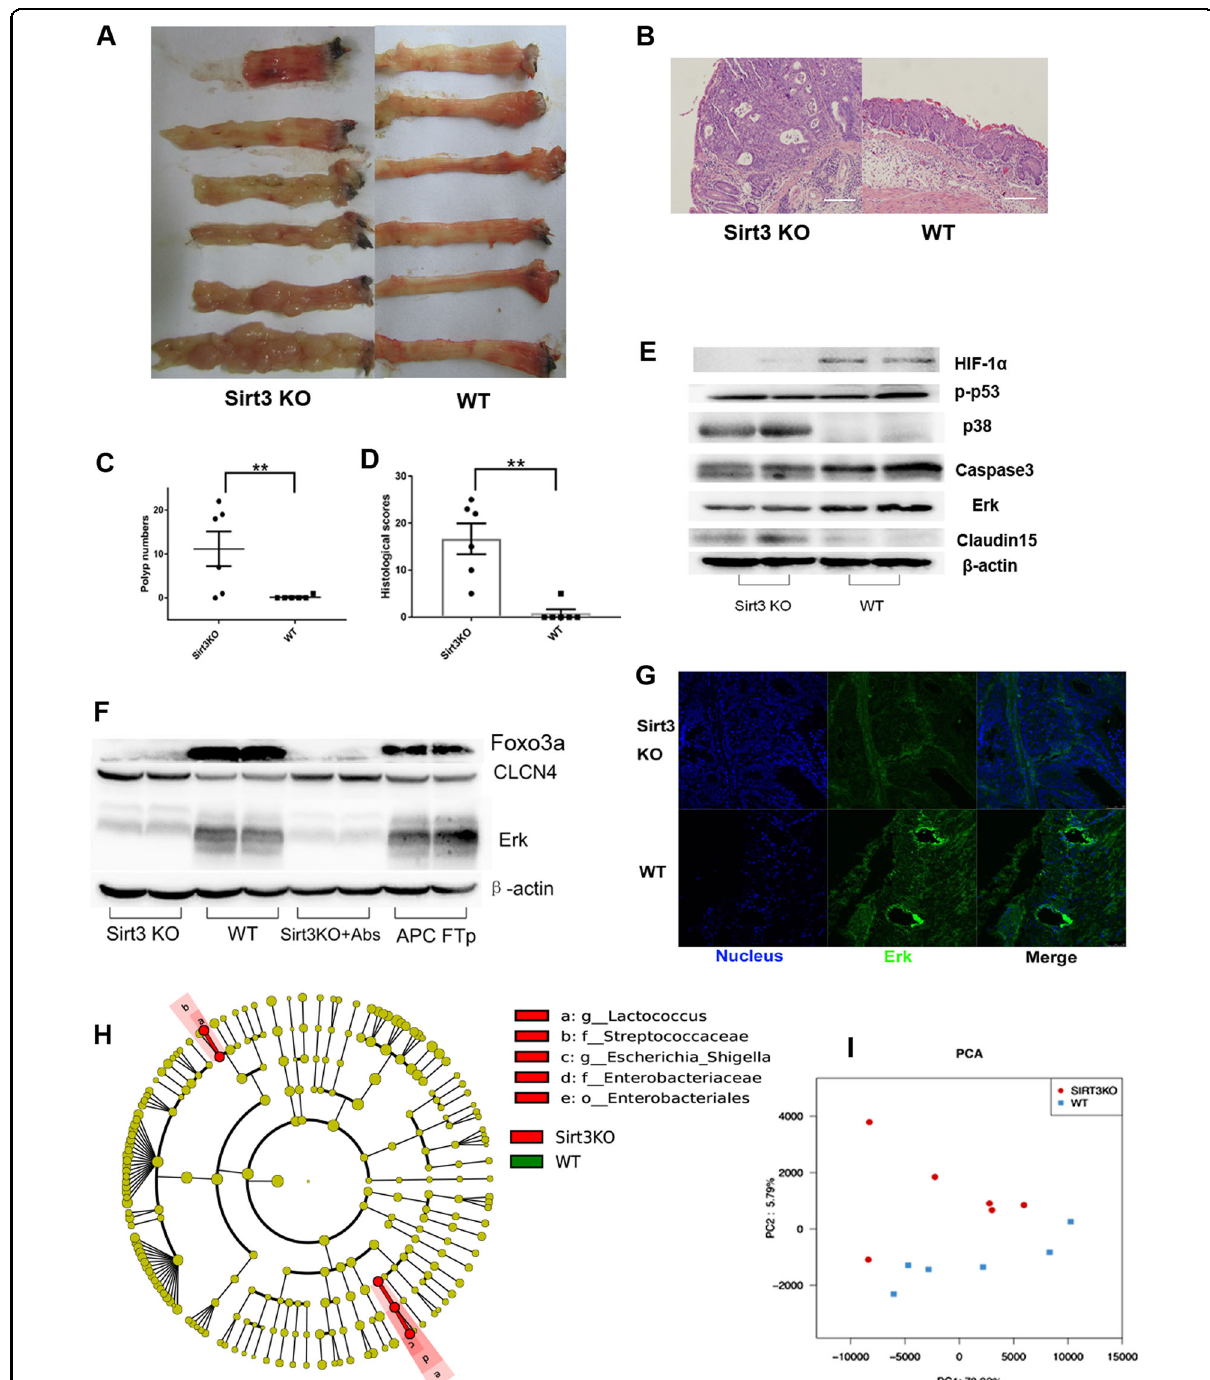
Fig. 3 Sirt3 de fi ciency results in increased susceptibility to colonic tumors. a Images of distal colons from SIRT3KO and WT mice after AOM/DSS tumorigenesis. b Representative HE staining of distal colon sections obtained from SIRT3KO and WT mice after AOM/DSS tumorigenesis. c Comparison of polyp numbers between SIRT3KO and WT mice ( n =6). Data are represented as the mean ± SEM. P <0.05; ** P <0.01; *** P <0.001; by unpaired Student ’ s t test. d Histological scores of distal colon sections from SIRT3KO and WT mice after AOM/DSS tumorigenesis ( n =6). e Western blots of intestinal HIF1- α , Erk, p-p53, p38, Claudin15 and caspase3 expression from SIRT3KO and WT mice after AOM/DSS tumorigenesis. f Western blots of liver CLCN4 and Erk expression from SIRT3KO and WT mice after AOM/DSS tumorigenesis. g Immuno fl uorescence staining of Erk (green) and nuclei (blue) in colons. Scale bars, 10mm. h Featured altered microbial communities between SIRT3KO and WT mice after AOM/DSS tumorigenesis ( n =6) from Illumina Miseq sequencing. Data were analyzed by the Mann – Whitney test. i PCoA of 16S rRNA gene-sequencing analysis of gut microbes obtained from the indicated mice and treatments ( n =6) from Illumina Miseq sequencing. PC1 and PC2 explain 78.32 and 5.79% of the variation, respectively. n no signi fi